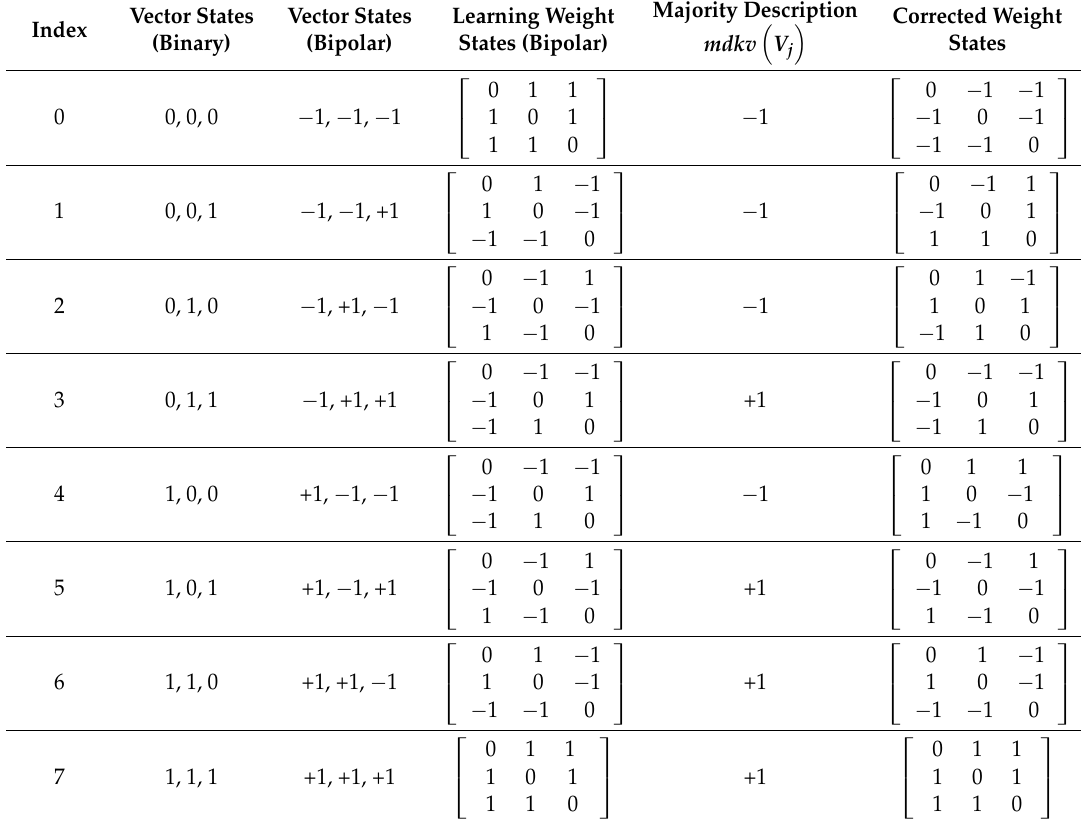
Table 3. All the possible vectors with their weight